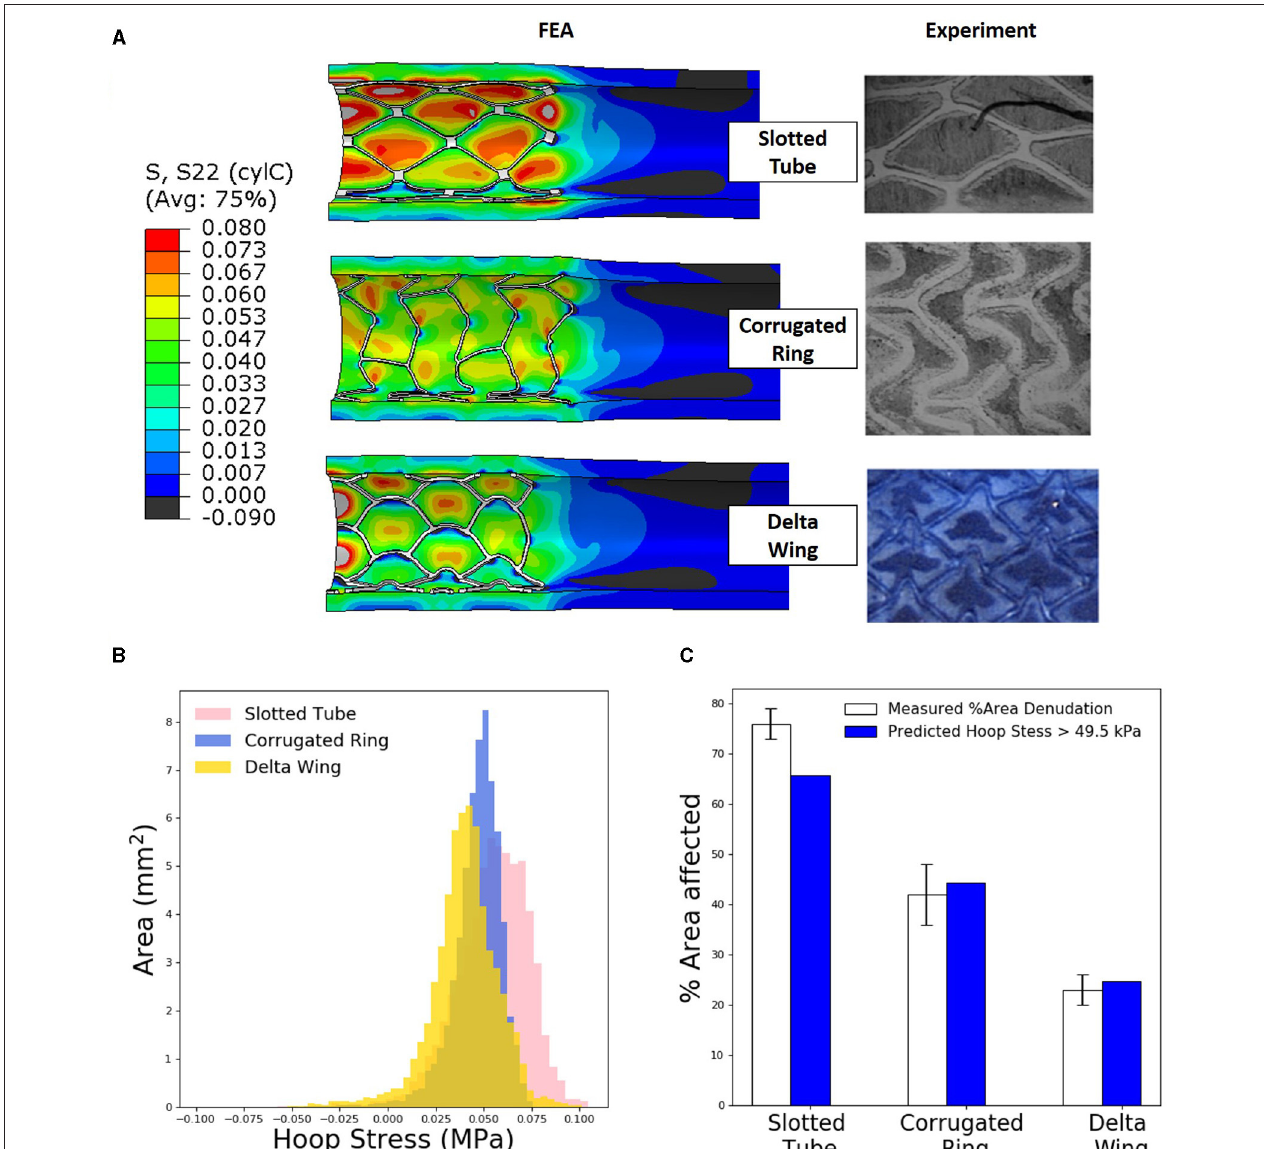
FIGURE 3 | Levels of tissue hoop (circumferential) stress due to stent expansion predicts sites of endothelial denudation. (A) Finite element analysis (FEA) predictions of arterial hoop stress (MPa) following deployment of three different stent designs compared with representative histological stains [slotted tube and corrugated ring adapted with permission (15)] for endothelial denudation following in vivo deployment of each design. (B) Distribution of arterial luminal surface area at given levels of hoop stress for each of the three stent designs considered. (C) Comparison of measured percent of area denudation from computerized morphometric analysis of arterial tissue vs. FEA predicted arterial surface area exposed to a hoop stress exceeding 49.5 kPa following deployment of each stent design.